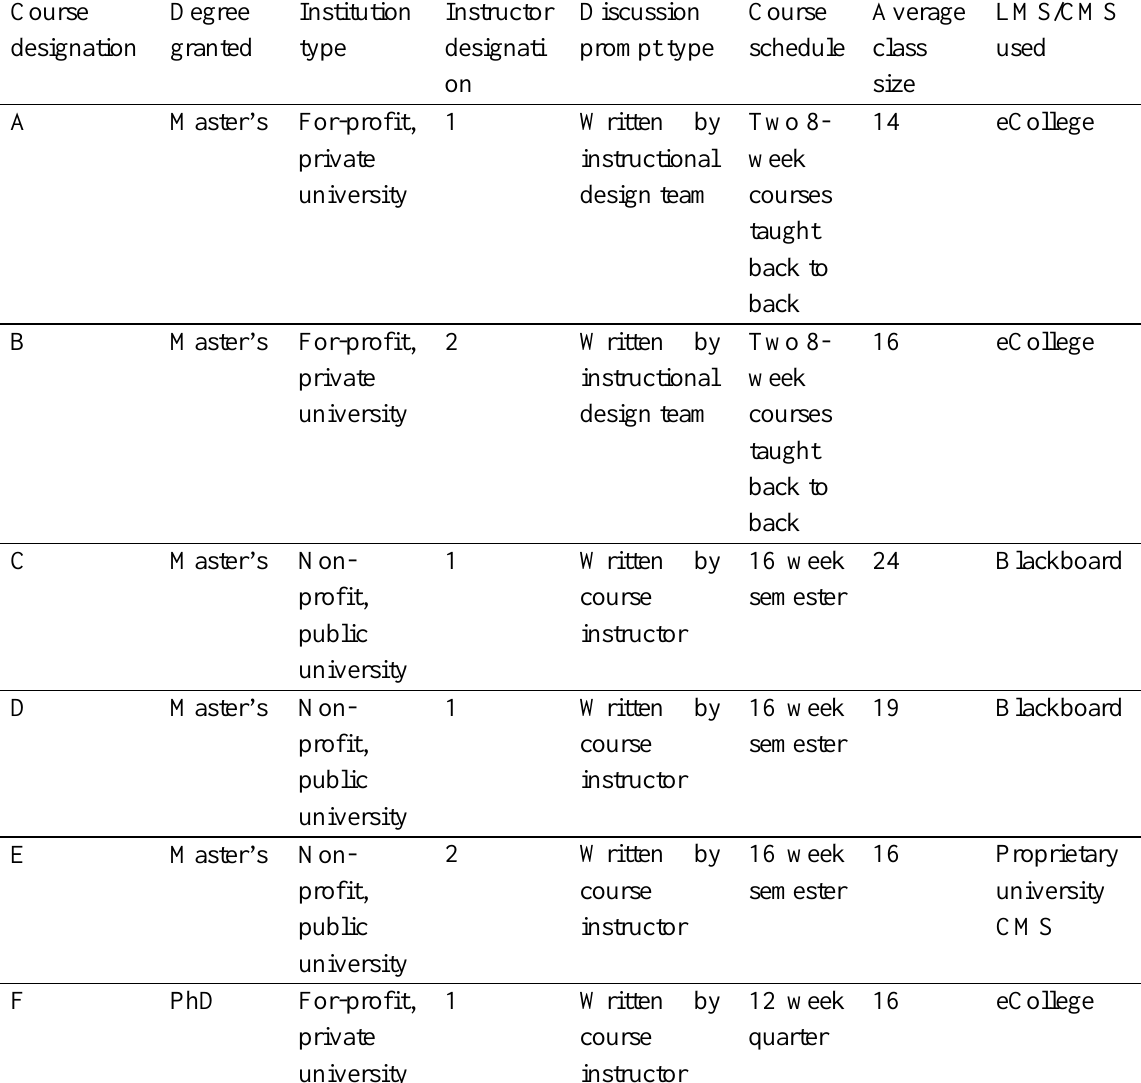
Table 1 Description of Courses Used to Create the Data Set